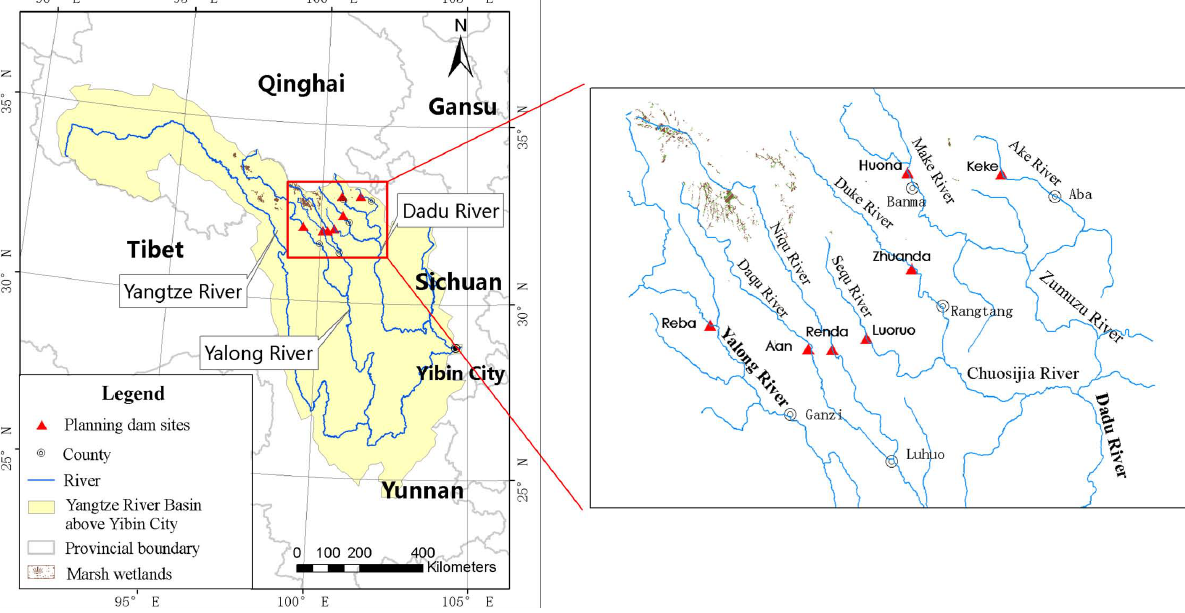
Fig. 1. Arrangement diagram of the